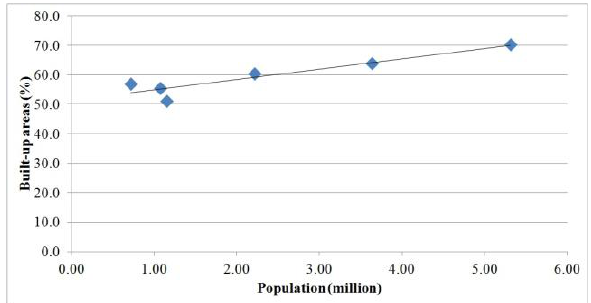
Figure 15. Relationship between the percentage of built-up areas and GDP without Edmonton City for 2005 ( R 2 = 0.84)